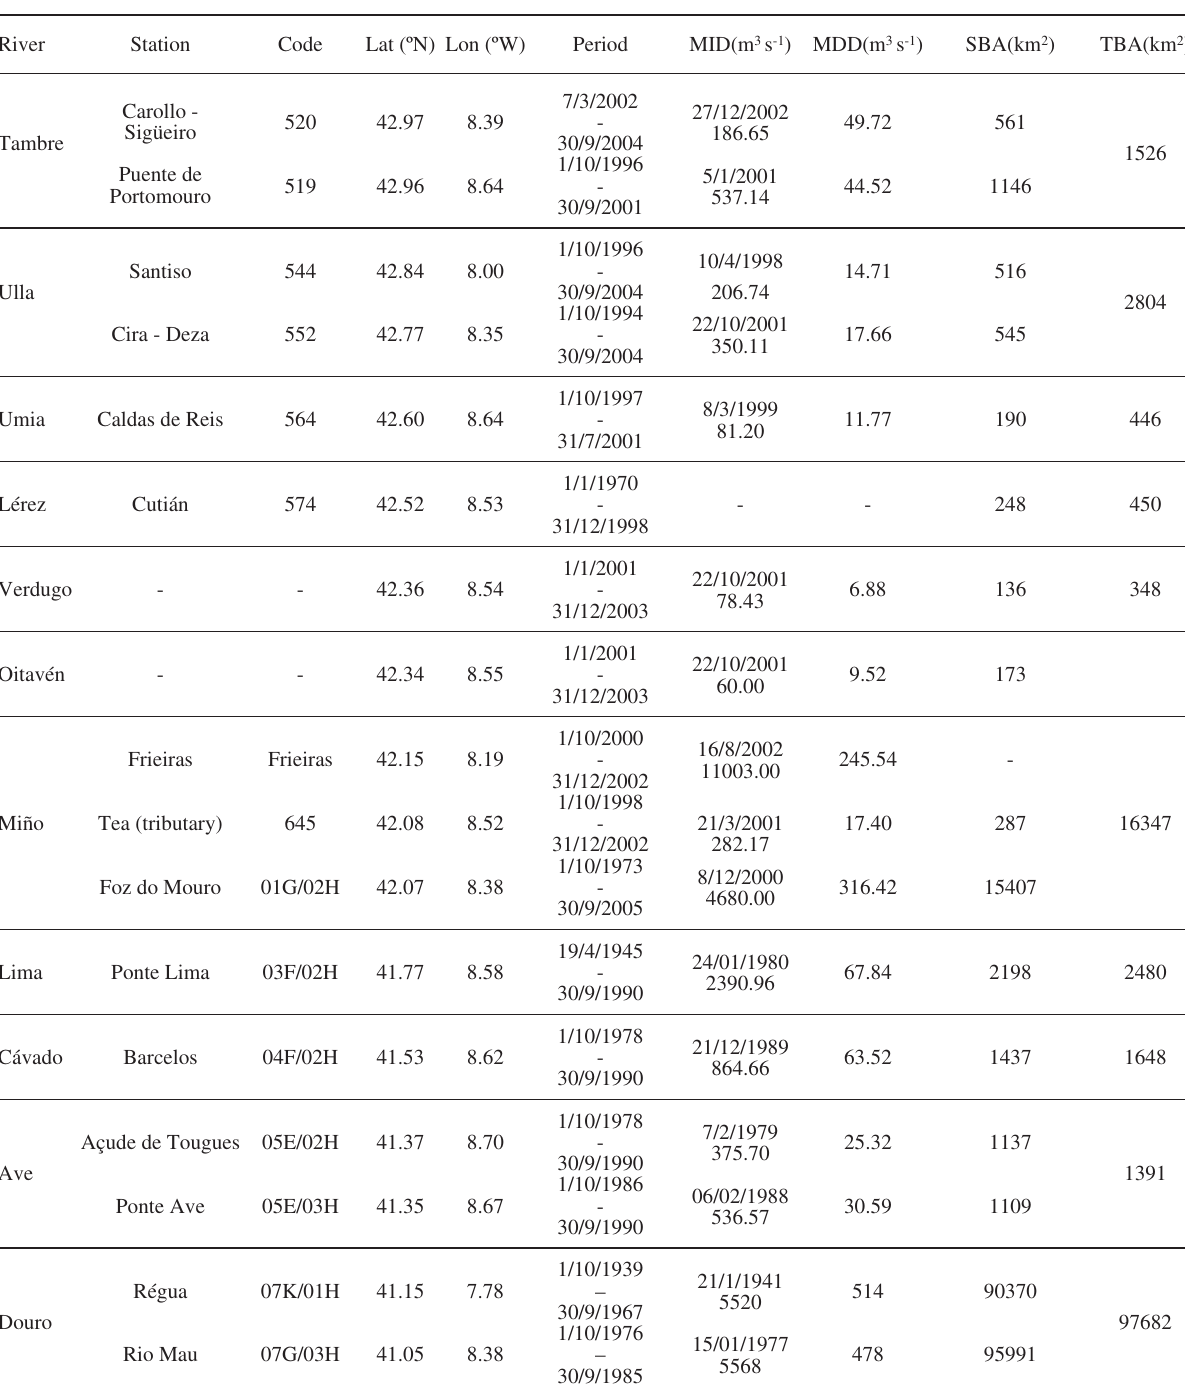
Table 1. – Gauging stations used in the study. Gauging codes are the same as those available on request to purveyor institutions. The location of the gauge, the maximum instantaneous discharge (MID), mean daily discharge (MDD), the area upstream from the gauging station (SBA) and the total basin area (TBA) are shown. The longest available time series have been employed in the analysis; there may be some gaps in time series.